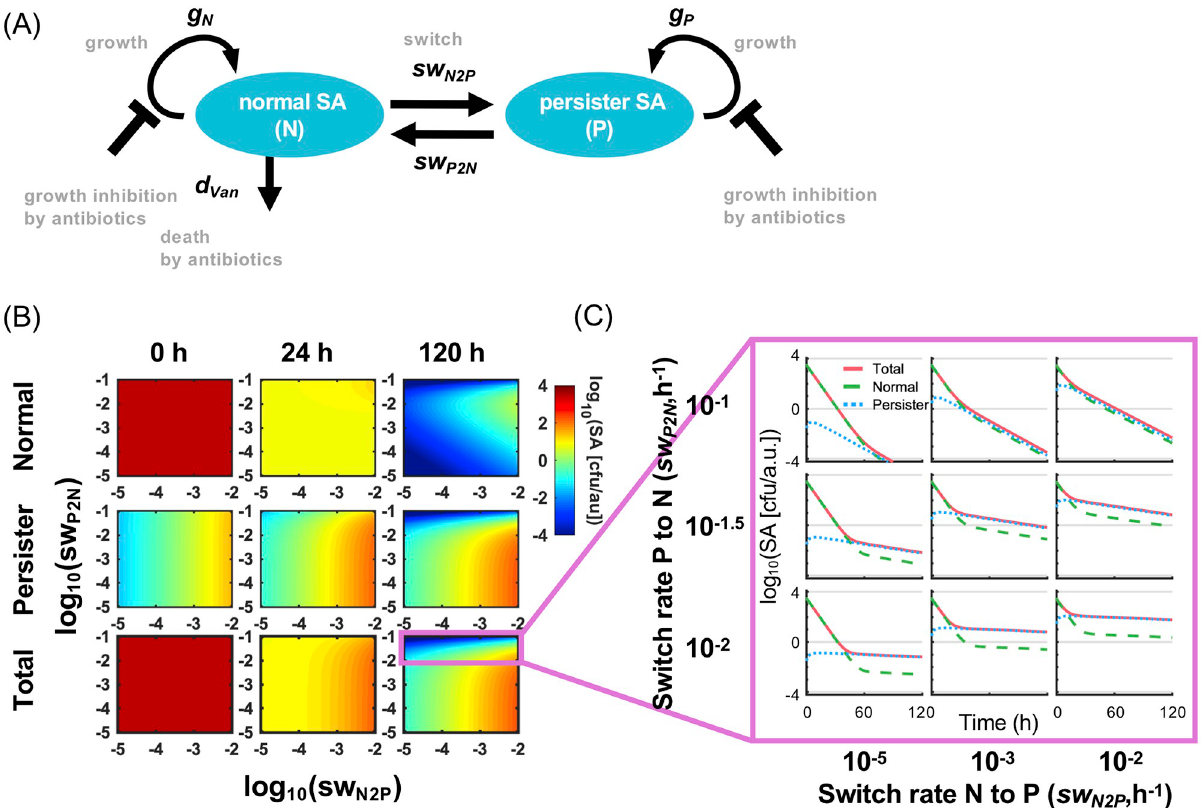
Fig 1. Dynamics of in vitro bacterial growth treated with antibiotics, vancomycin. (A) Schematic diagram of the mathematical model for in vitro growth. The diagram depicts the two state variables as blue ovals, normal and persister SA, whose abundances are controlled by growth rate, death rate by vancomycin ( Van ), and switch rates. The mathematical model is able to recapitulate not a phenomenon of resistance, but an in vitro persistence against antibiotics. (B) Heatmaps showing the number of normal, persister and total SA at 0, 24, and 120 h post-vancomycin addition as a function of switching rate sw and sw . The pre-simulations were run with N(0) = 1 colony-forming unit per arbitrary unit (cfu/a.u.) and P(0) = 0 cfu/a.u. N2P P2N without antibiotics for 8 h, then vancomycin was added (0 h post-vancomycin addition). The parameter values used are shown in Table 1. (C) The number of total, normal and persister SA graphed as a function of time for each combination of sw